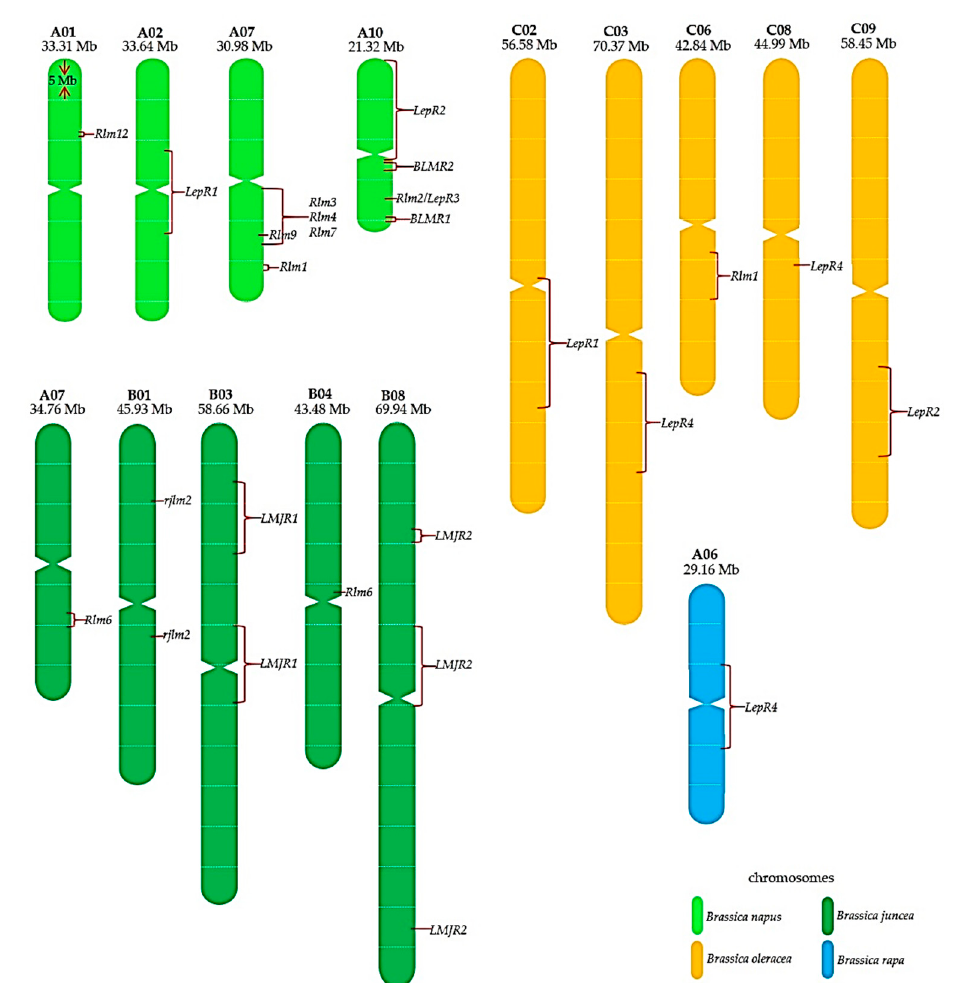
Figure 2. Current physical location of the known blackleg R genes based on quantitative trail loci (QTL) and candidate gene positions. Mb = million base pairs; B. napus pangenome [69–71], B. oleracea pangenome [72,73], B. juncea genome v. 1.5 [74] and B. rapa genome v. 3.0 [75]. Table 2. List of candidate genes harbouring resistance to Leptosphaeria maculans with their reported resistance gene analog (RGA) function along with their closest gene ortholog having disease resistance/other function. Gene (Position) Candidate Genes RGA Type Gene Ortholog (TAIR10) Molecular Function